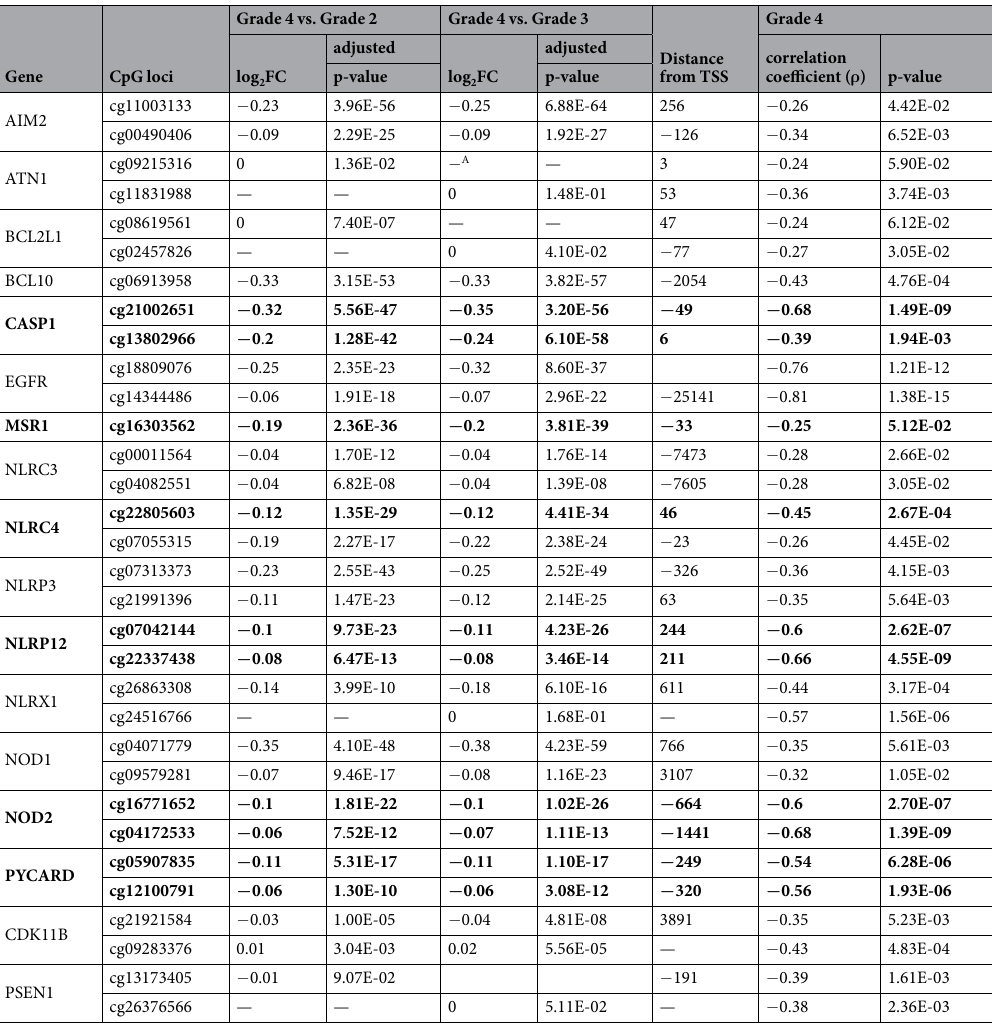
Table 2. Differentially methylated CpG loci for NLRs and NLR-associated genes in glioma. Abbreviations: FC, fold change; TSS, transcription start site. A Denotes log 2 FC insignificant.